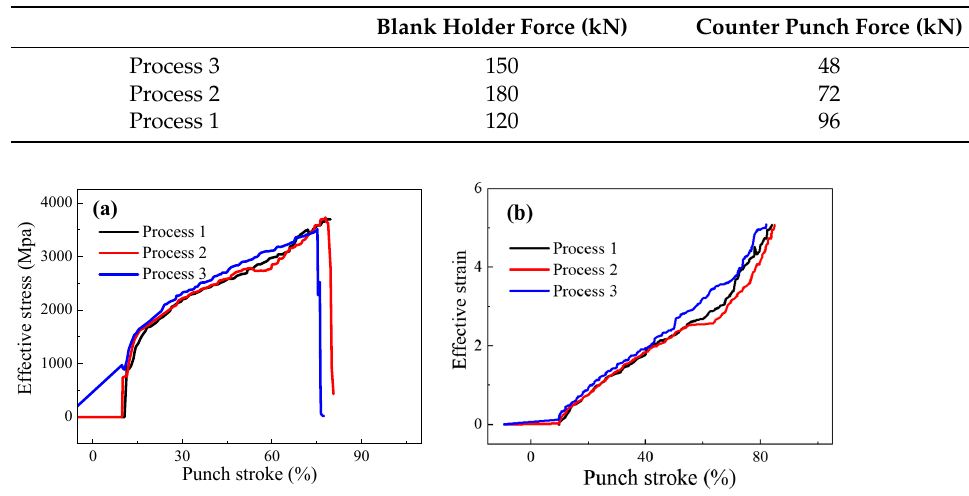
Table 10. Blank holder force and counter punch force in three groups of simulations.